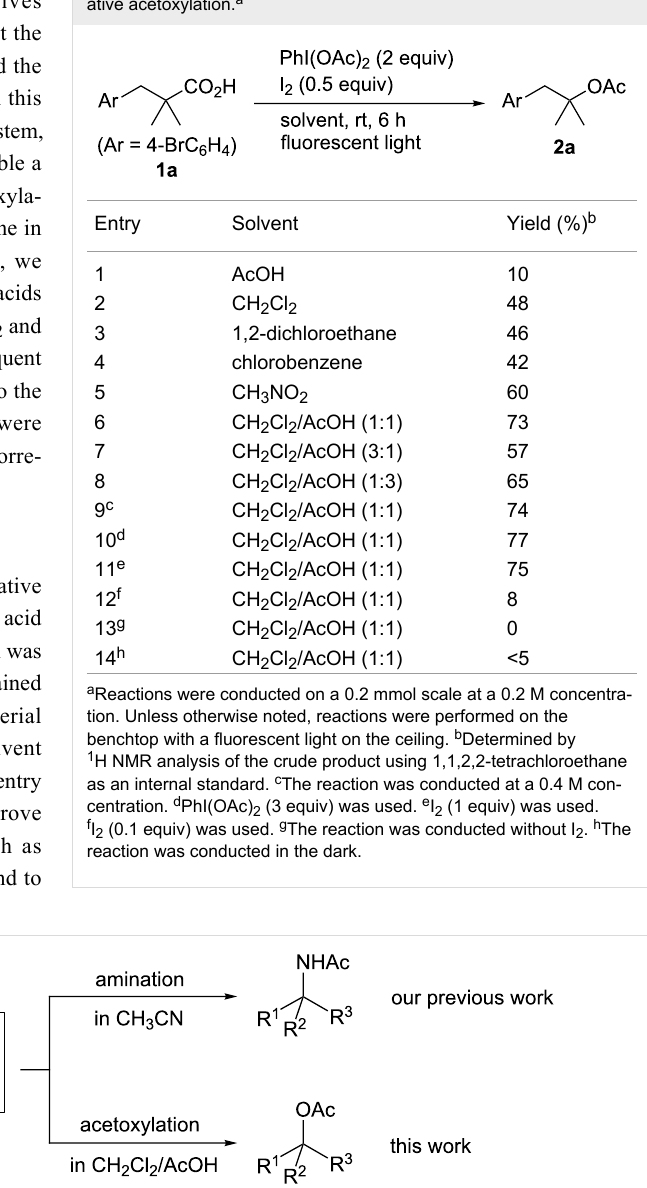
Table 1: Effect of solvents and reaction parameters on the decarboxyl- ative acetoxylation. a